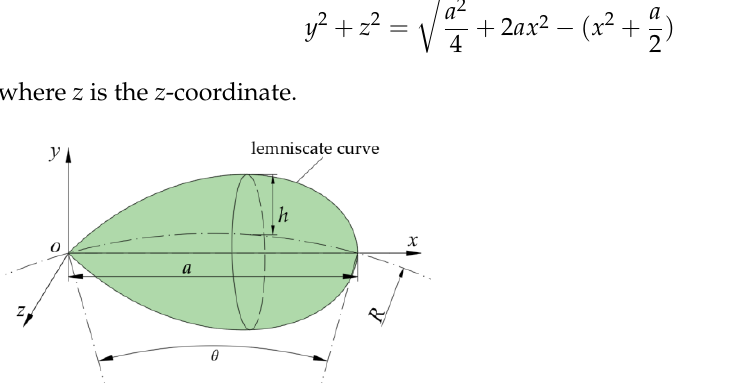
Figure 3. Lemniscate curve and base circle edge line diagram. Note: R is the base circle radius; a is the parametric equation coefficient; θ is the corresponding central angle theta; h is the bulge height.